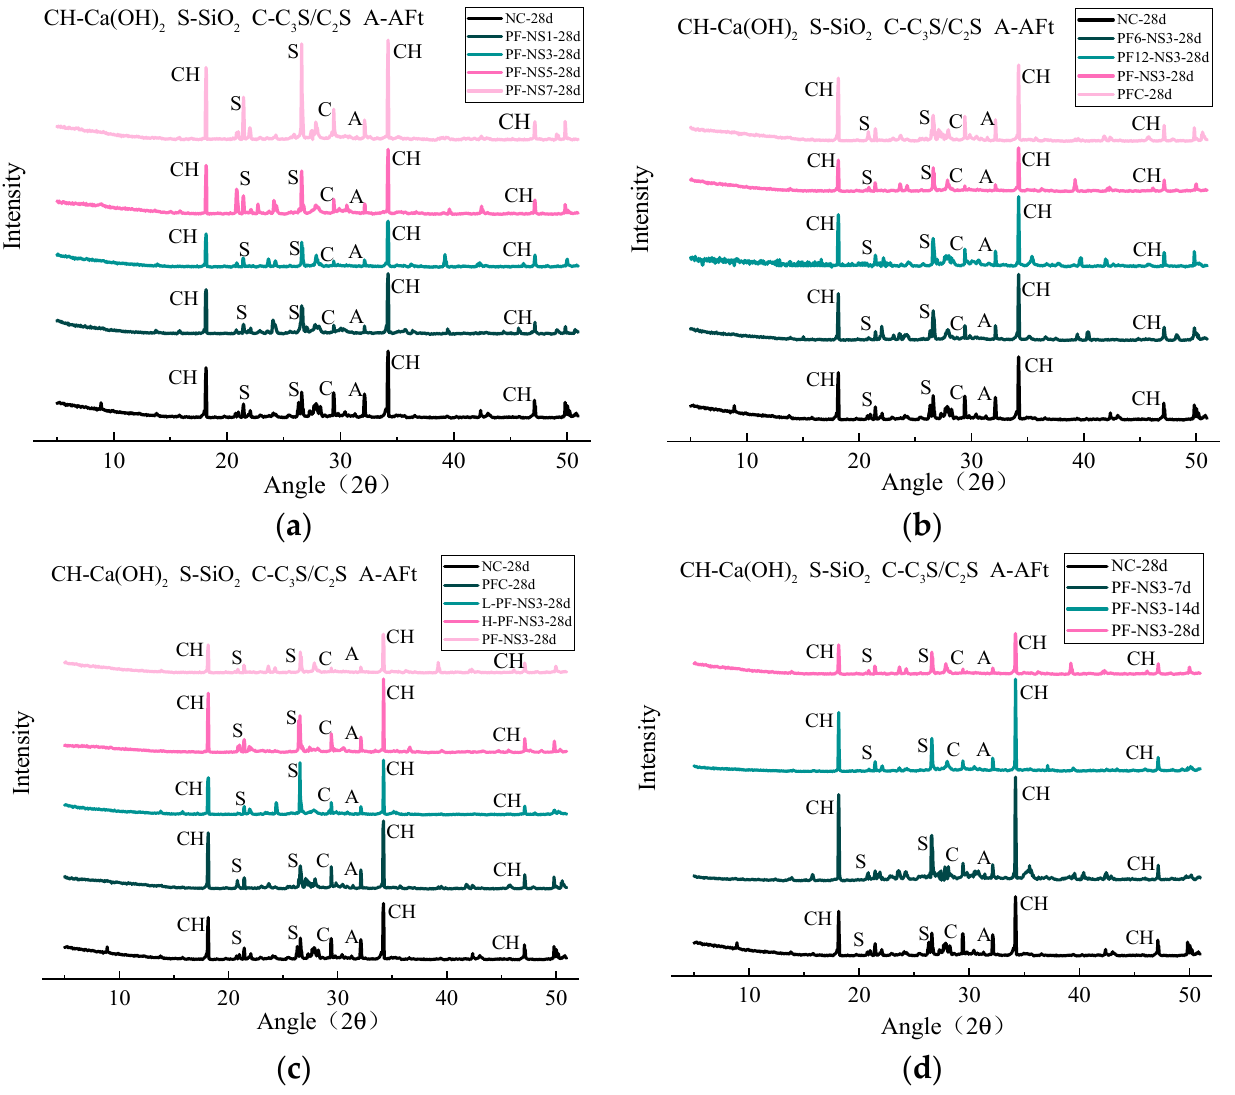
Figure 4. XRD patterns of concrete with different dosages of nano-SiO 2 and polypropylene fiber. ( a ) varied dosage of nano-SiO 2 , ( b ) varied dosage of polypropylene fiber, ( c ) varied dosage of water, ( d ) varied curing time.